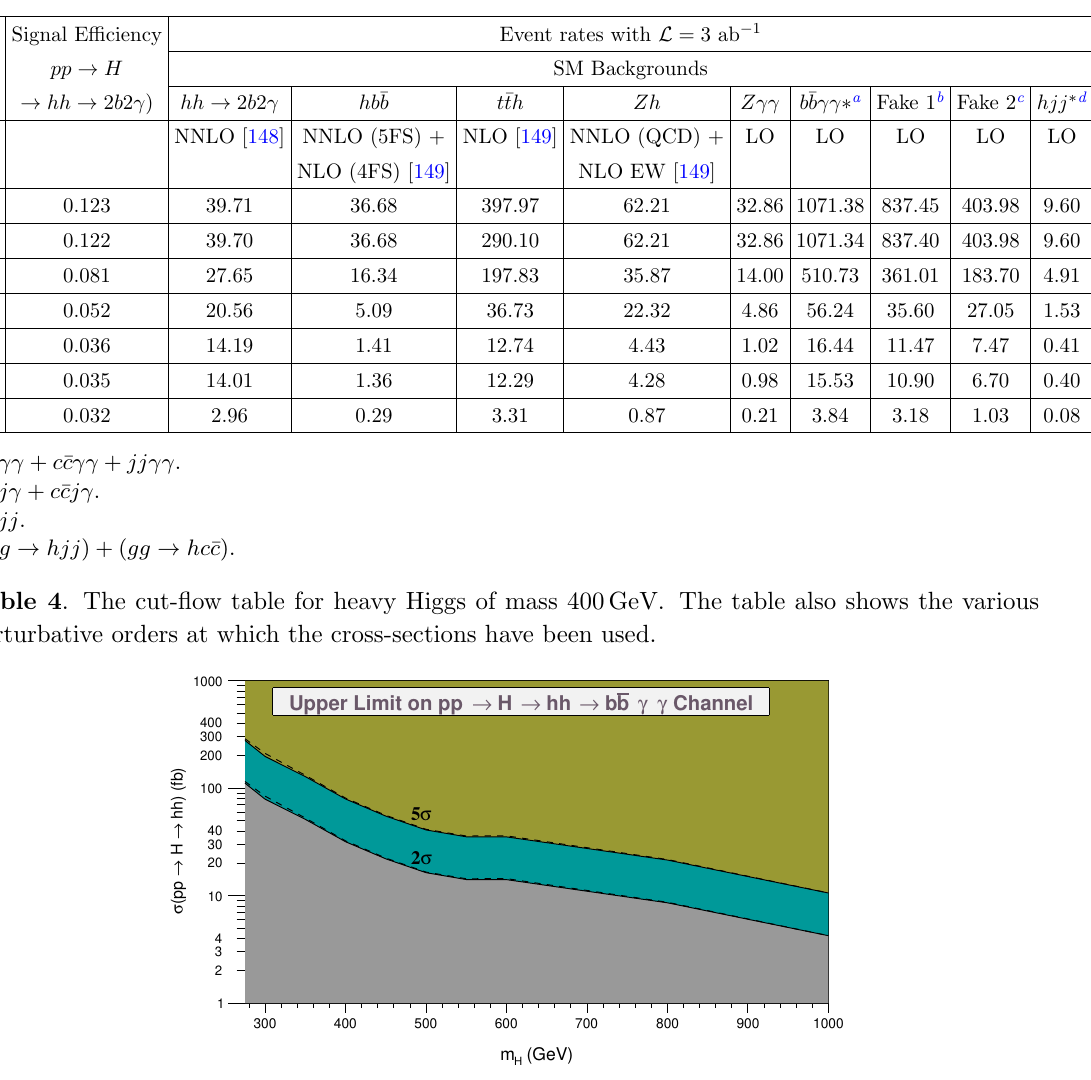
Figure 8 . Upper limit on (cid:27) ( pp with cut-based analysis. The solid (dashed) lines show the 2 (cid:27) -5 (cid:27) band on taking 0% (5%) systematic